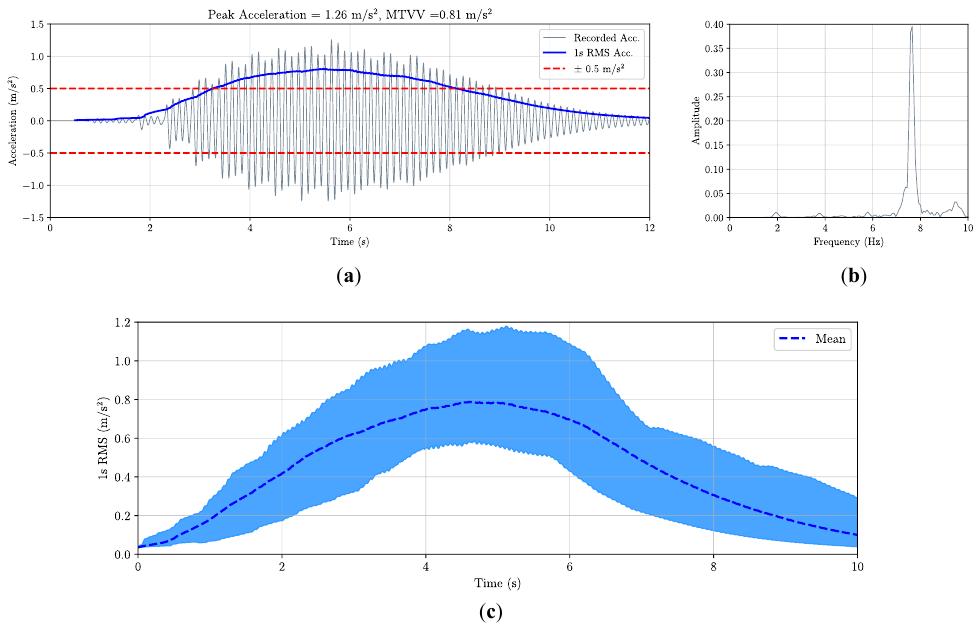
Figure 6. Experimental results for a single pedestrian walking at 1.9 Hz: ( a ) Acceleration reponse at midspan when the Test Subject 2 crossed the bridge. ( b ) Response in the frequency domain. ( c ) Mean 1s RMS acceleration and its dispersion considering 18